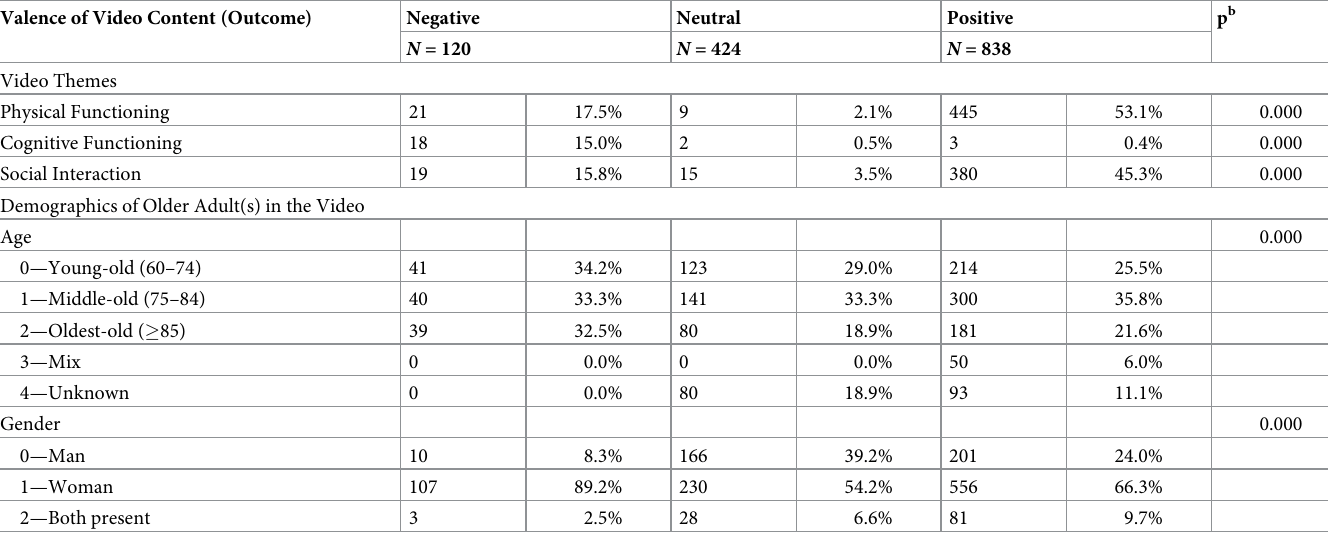
a Table values are N and column % for respective predictors and covariates. b P-value is for χ 2